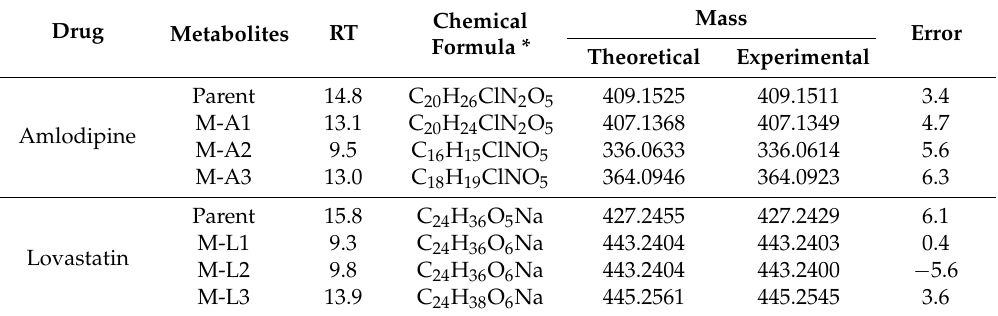
Table 2. Major metabolite pattern of amlodipine and lovastatin in human liver microsomes.